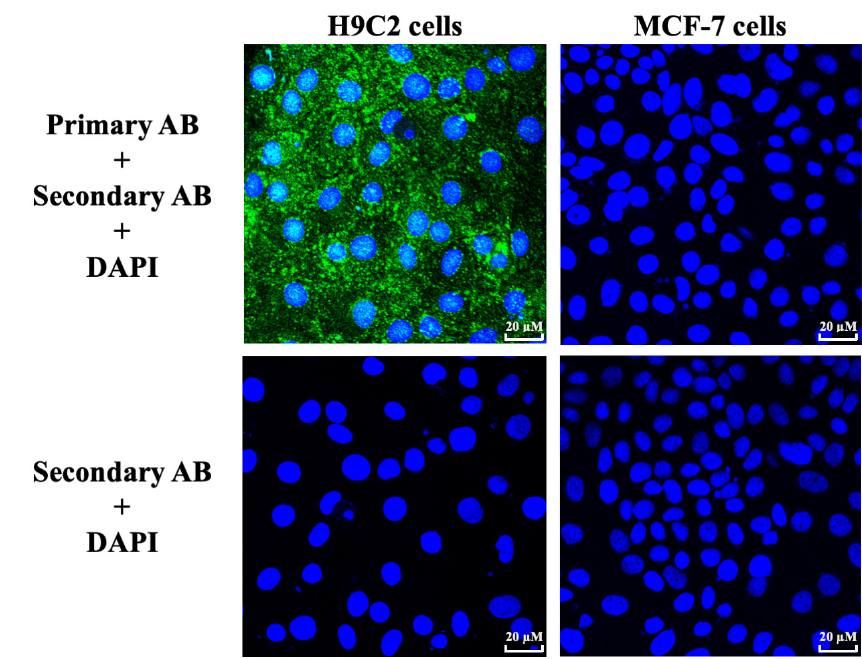
Figure 1. Indirect immunofluorescence staining of the GPR91 receptor on H9C2 and MCF-7 cells. Cells were labeled with 4 (cid:48) ,6-diamidino-2-ph é nylindole (DAPI) and rabbit anti-GPR91 antibody (AB) revelated with fluorescent Alexa Fluor 488 secondary AB. A control without primary AB was made for both cell